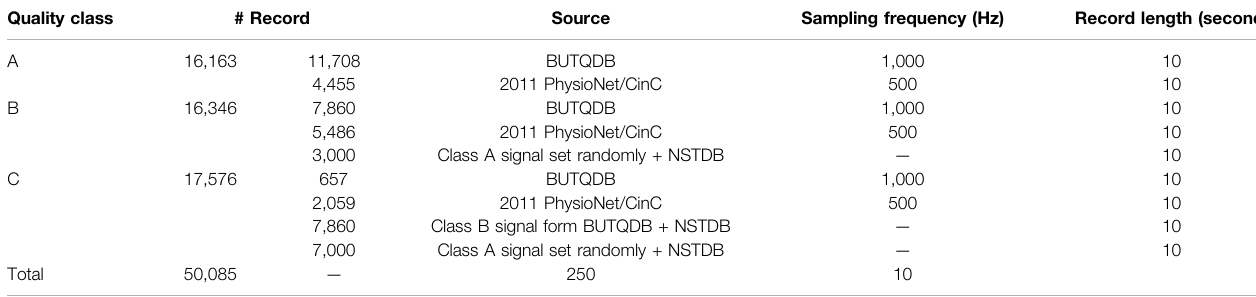
TABLE 2 | Dynamic ECG quality assessment database